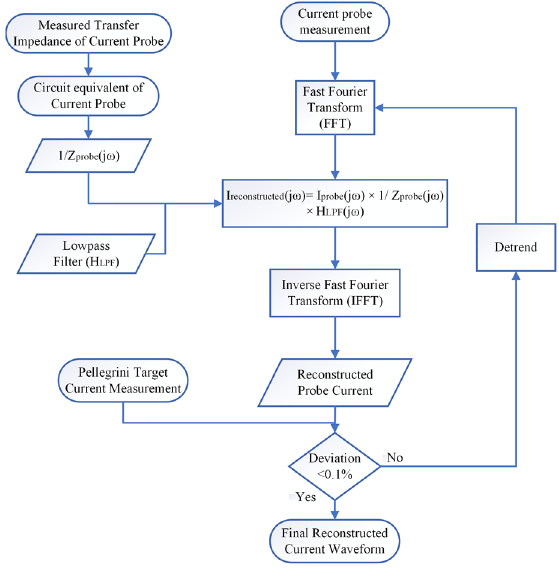
Figure 3. Flowchart of the frequency response compensation method including the detrend opti- mization